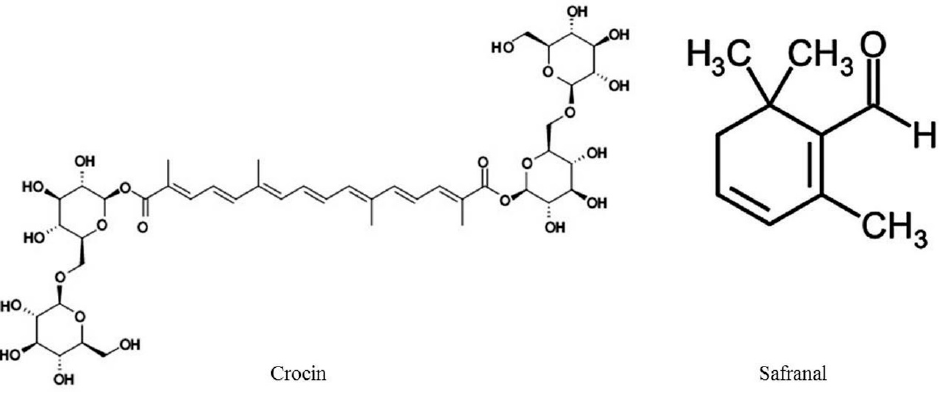
Figure 1. Molecular structures of C. sativus components crocin and safranal.